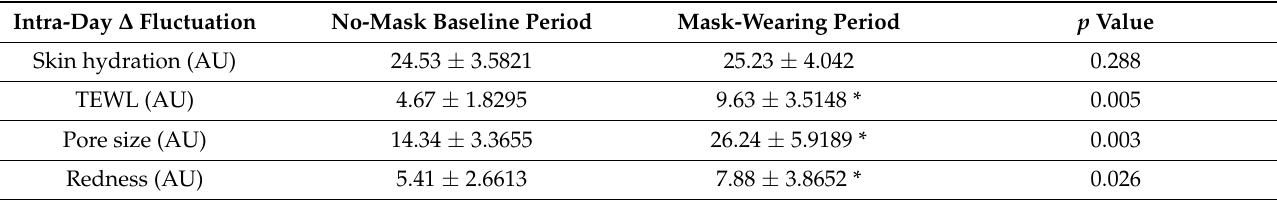
Table 2. Intra-day Δ fluctuation in facial skin variables. Table 2. Intra-day ∆ fluctuation in facial skin variables.